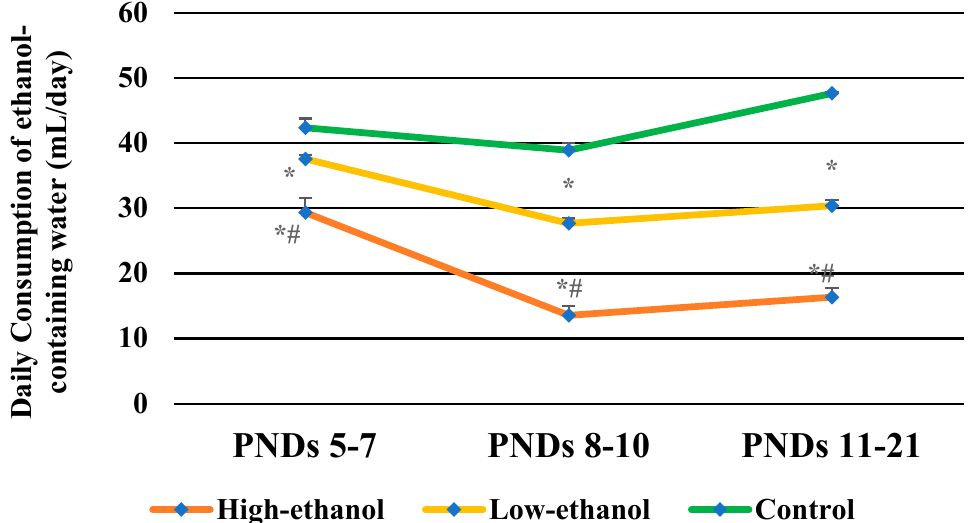
Figure 1. Daily consumption of ethanol-containing water in rat dams on PNDs 5–7, 8–10 and 11–21; Data are expressed as the mean ± SEM; * p < 0.01 compared with that in the control dams; # p < 0.001 compared with that in the low-ethanol dams; the number of dams was 6 in each group. Table 1. Effects of lactational ethanol exposure on landmarks of physical growth in rat pups. Pups Weaning High-ethanol